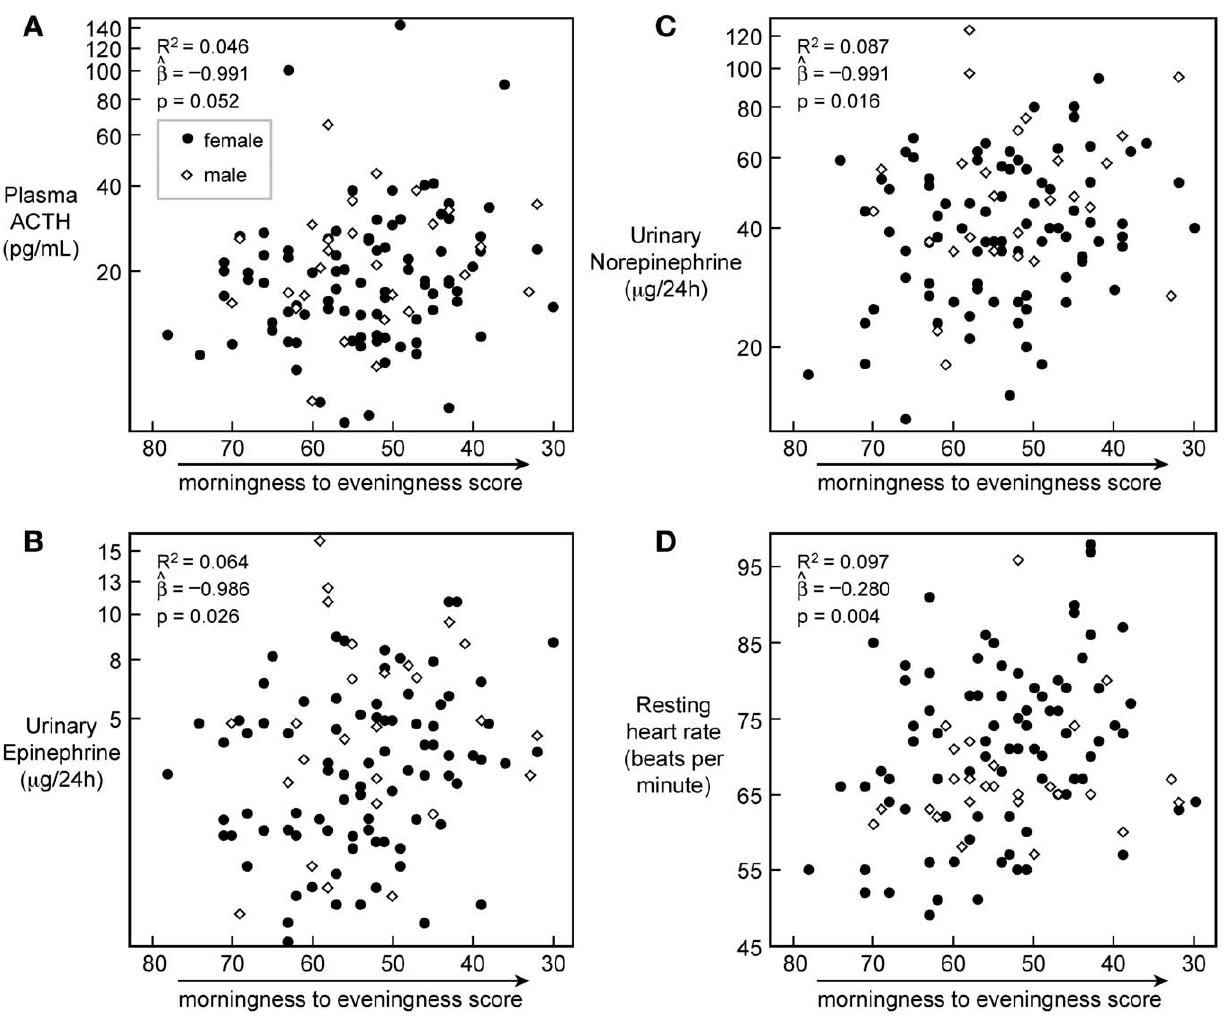
Figure 4. Stress hormones and heart rate vs. chronotype score. Chronotype scores on the horizontal axis are regressed against plasma ACTH ( n =118; A), 24 h urinary epinephrine ( n =110; B) and norepinephrine ( n =114; C), and resting heart rate ( n =113; D). R 2 for the gender-corrected model is reported, and slope and p -value for the prediction of chronotype score on variables in the model are given. Closed circles represent women, open diamonds represent men.